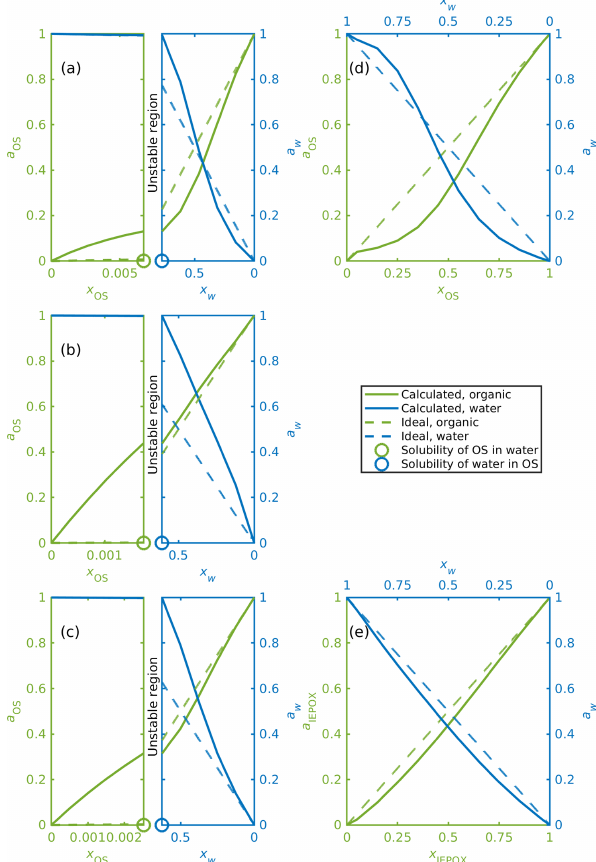
Figure 6. Activities of OS, IEPOX and water in binary mix- tures; (a) α -pinene-OS-5, (b) β -pinene-OS-1, (c) limonene-OS-1, (d) isoprene-OS-2, (e) δ 1 -IEPOX. The left-hand sides of panels (a– c) show the water-rich phase, and the right-hand sides show the cor- responding organic-rich phase.